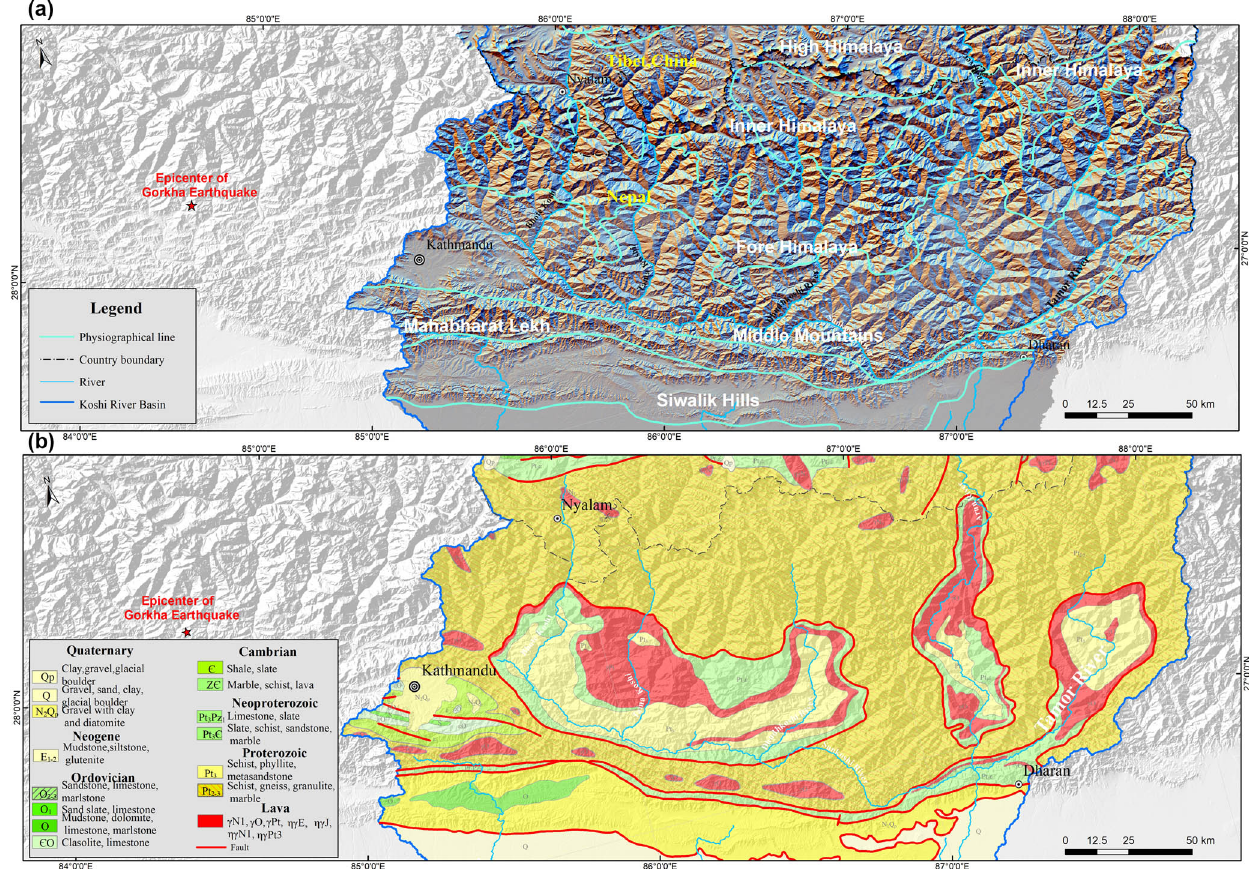
Figure 1. Maps showing the study area. (a) Physiographic zones of the Koshi River basin. (b) Geological map showing the main geological zones (Dhital, 2015; Zhang et al., 2016).